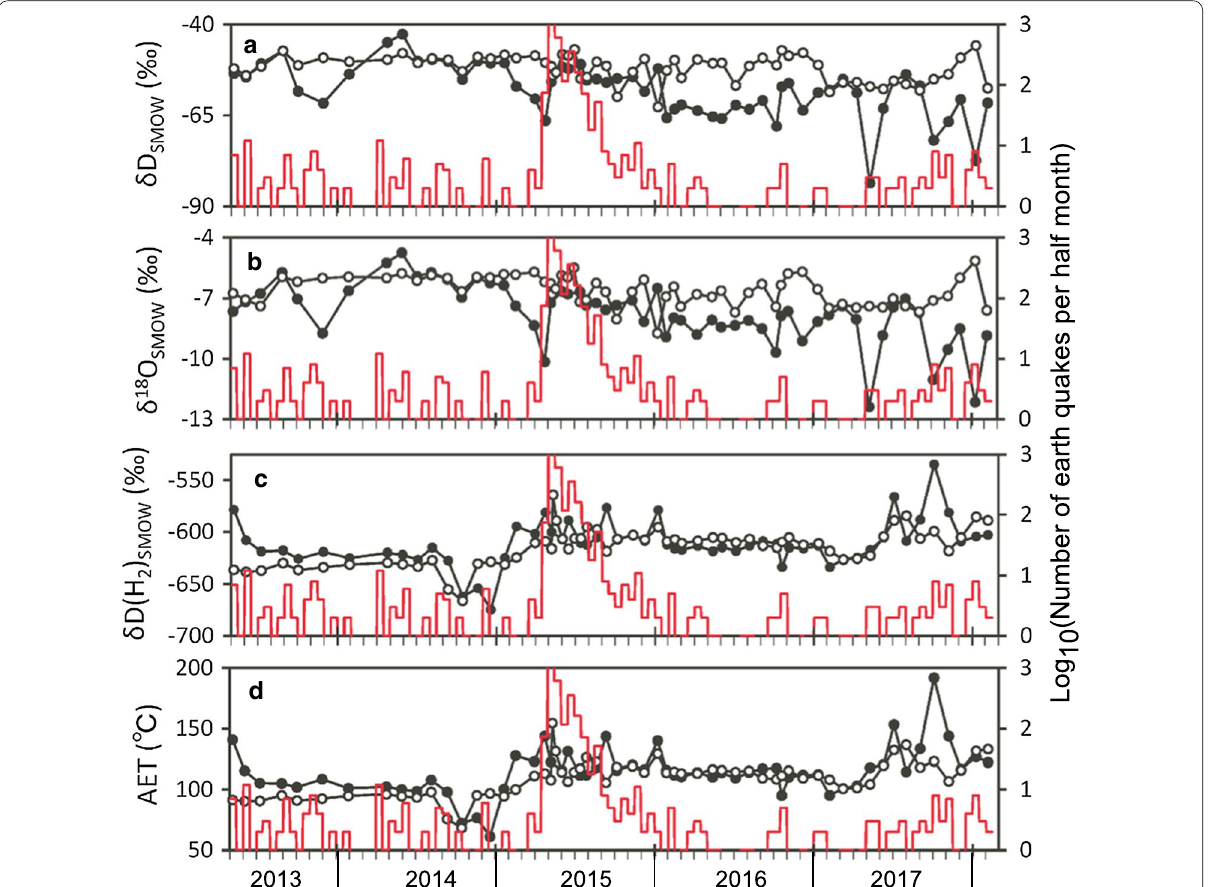
Fig. 4 Time variation of isotopic ratio of H 2 O and H 2 in fumarolic gases with AET. Solid and open circles indicate the values for the fumarole N and S, respectively. Red curve indicates the number of earthquakes per half month observed at Hakone